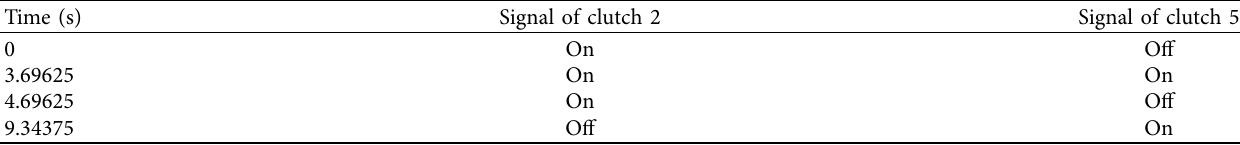
Table 9: Signal for clutch on/of.